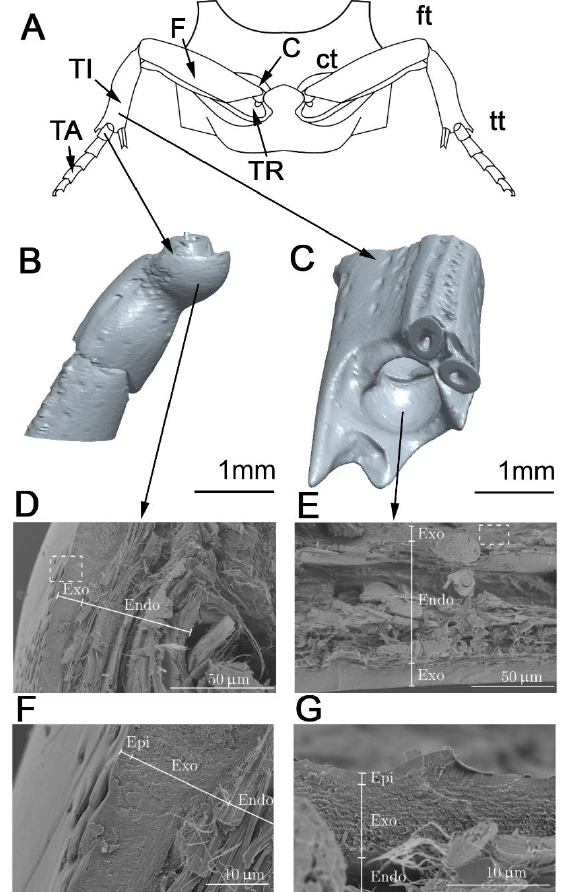
Figure 1. The mesothoracic leg pair of P. marginata ( A ) and the tibia ( C ) and tarsus ( B ) segmented from µCT images. Scanning electron microscopy (SEM) images of the cross-fracture of the contacting surfaces indicates the location of the detailed images F and G for the overview D and E. C: coxa; TR: